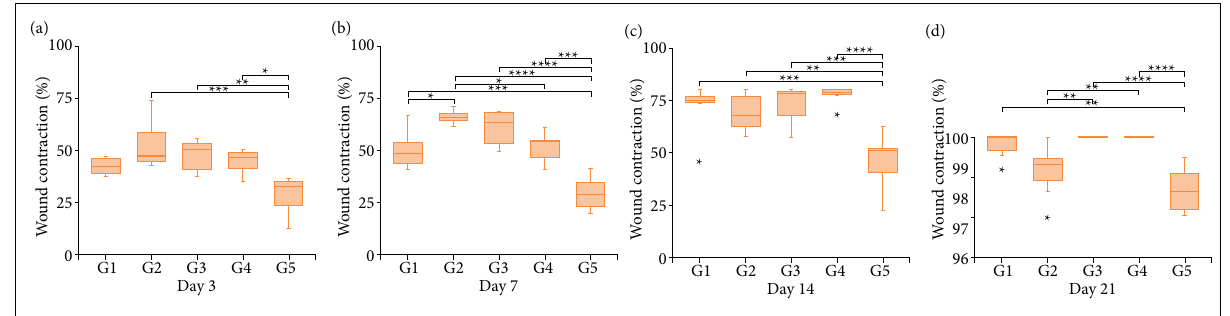
Figure 1 - Wound contraction (percentage) of excisional wounds experimentally induced in rats and treated with Hancornia speciosa latex-based cream-gel. Statistical test: one-way analysis of variance (ANOVA) test and Tukey’s post-test, with significance level of p < 0.05.